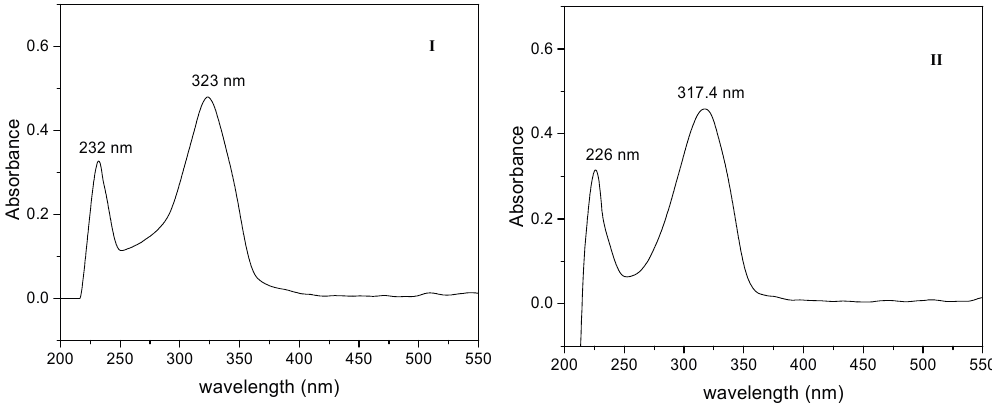
Figure 5. Absorption spectra of ( I ) and ( II